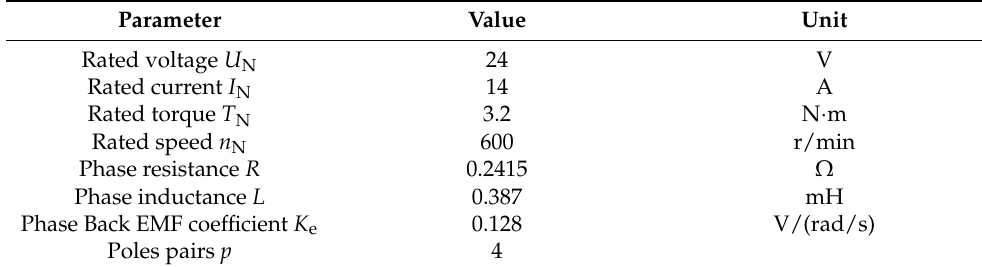
Table 1. The parameters of the